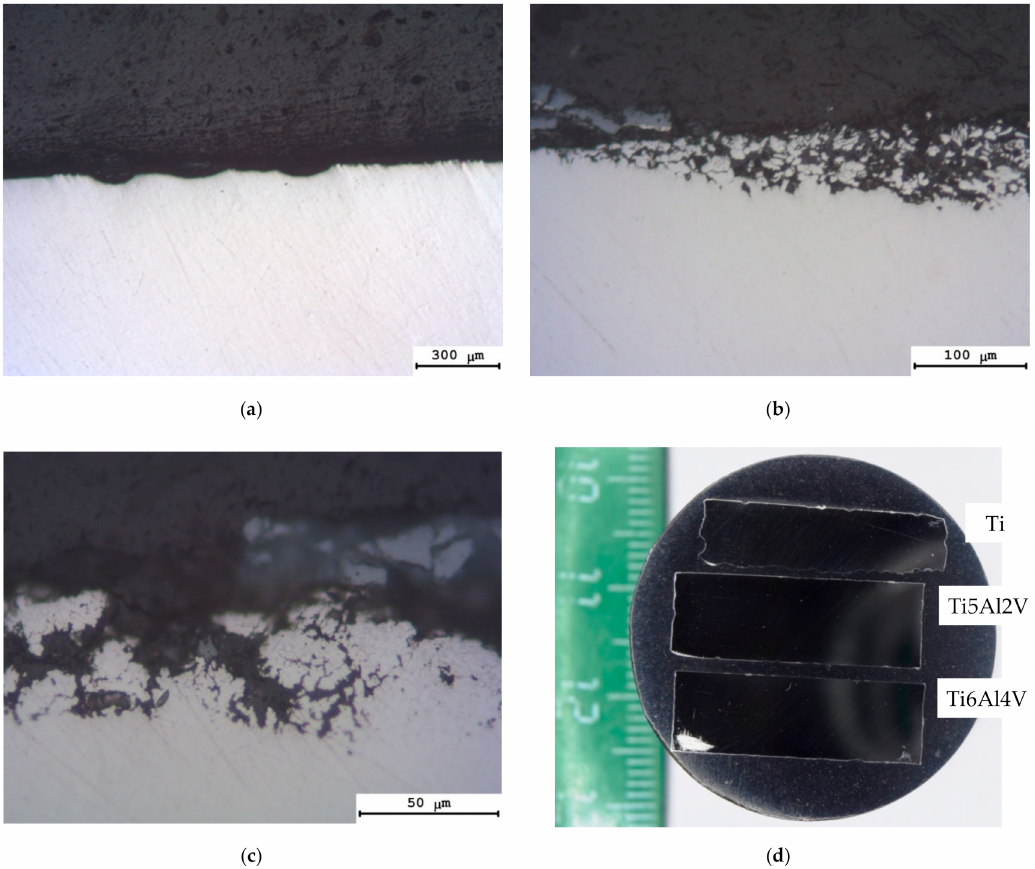
Figure 10. Optical microscopy images of the corrosion destruction character of the Ti alloys’ specimens after HSC testing: ( a , d )—Ti; ( b , d )—Ti5Al2V alloy; ( c , d )—Ti6Al4V alloy.